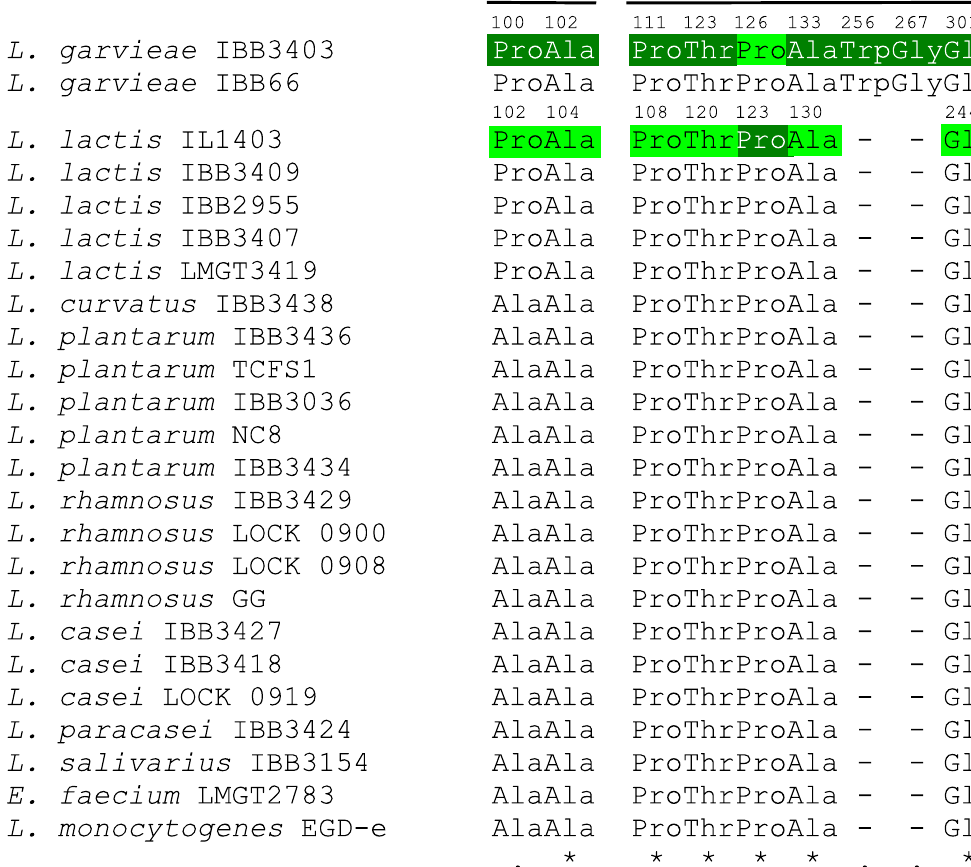
Figure 1. Alignment of Man-PTS IIC and IID L . garvieae IBB3403 and L . lactis IL1403 substituted amino acids (missense mutations) in different species. Amino acid substitutions (missense mutations) introduced by spontaneous mutation or by site-directed mutagenesis are highlighted dark green or light green, respectively, and their counterparts in other species are not highlighted. Numbers indicate positions of substituted amino acids in L . garvieae IBB3403 and L . lactis IL1403. Asterisks indicate fully conserved residues, single dots - weakly conserved